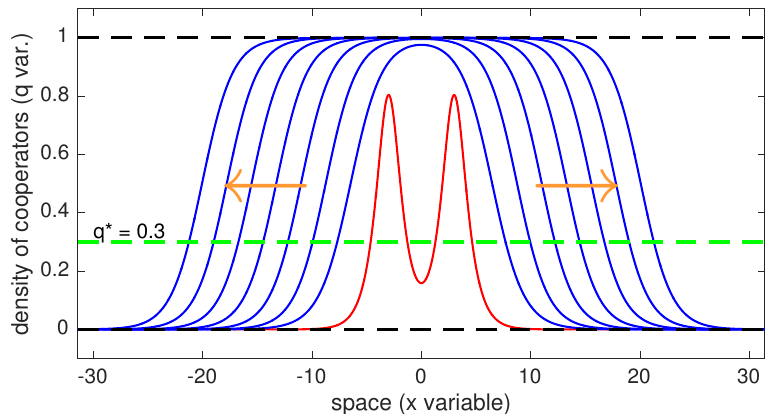
Figure A2. The figure shows another numerical simulation in 1D where the initial datum is a two 0.8 0.8 + picked cluster, namely: q 0 = . Even if in a certain interval of the initial cosh ( x − 3 ) cosh ( x + 3 ) datum’s domain cooperators are below the threshold they can still invade the whole